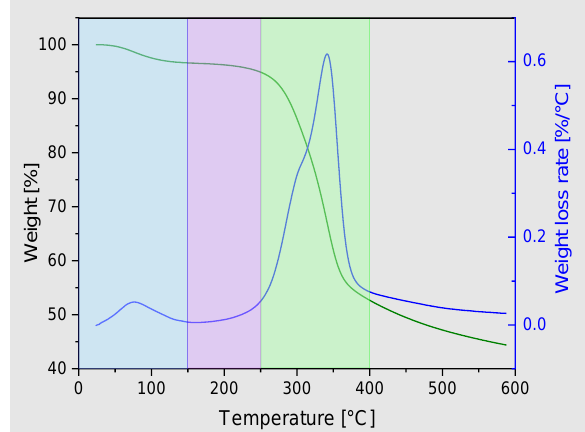
Figure 5. TG/DTG for rice husk.